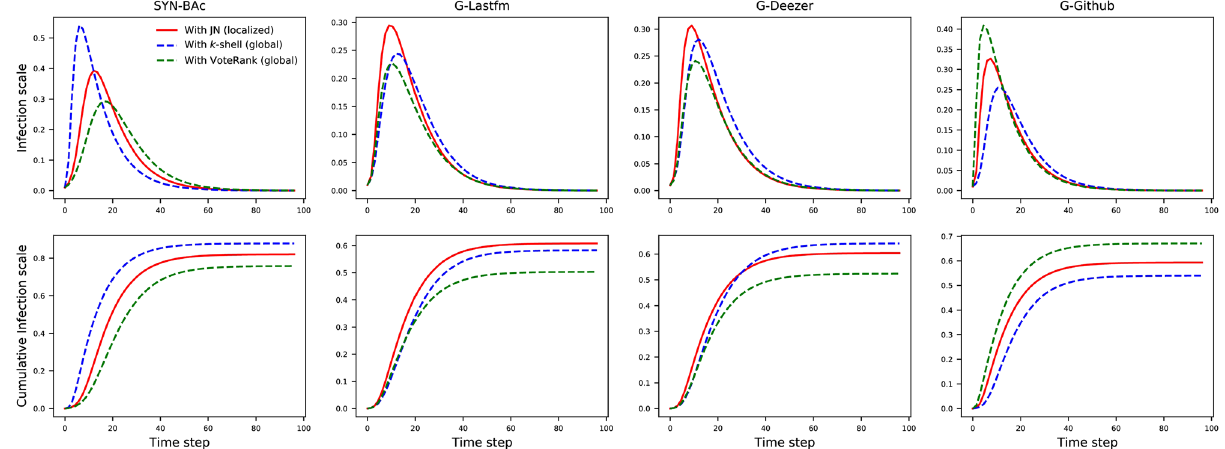
Figure 9. The infection scale (top row) and cumulative infection scale (bottom row) on four networks with 10% of nodes removed under various strategies, where β = 1.5 , γ = 1 and p = 0.01 . Immunizing the same number of nodes identified by JN, the top k -shell, and the top VoteRank leads to different changes to the network’s connectivity. JN reaches an intermediate final infection scale on SYN-BAc, G-Deezer, and G-Github networks. In the G-Lastfm network, JN shows the largest infection scale but is in fact only 0.04 greater than that of k -shell. The results are averaged over 20 independent